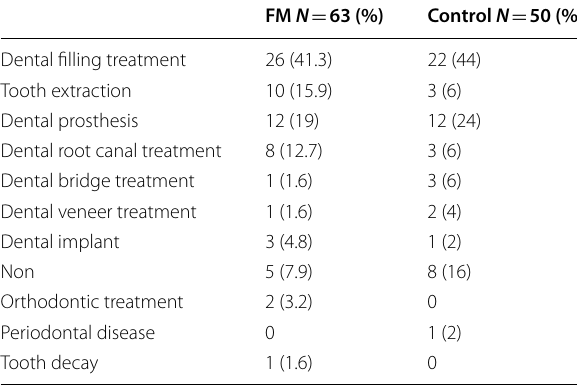
FM, fibromyalgia syndrome; N, subject number